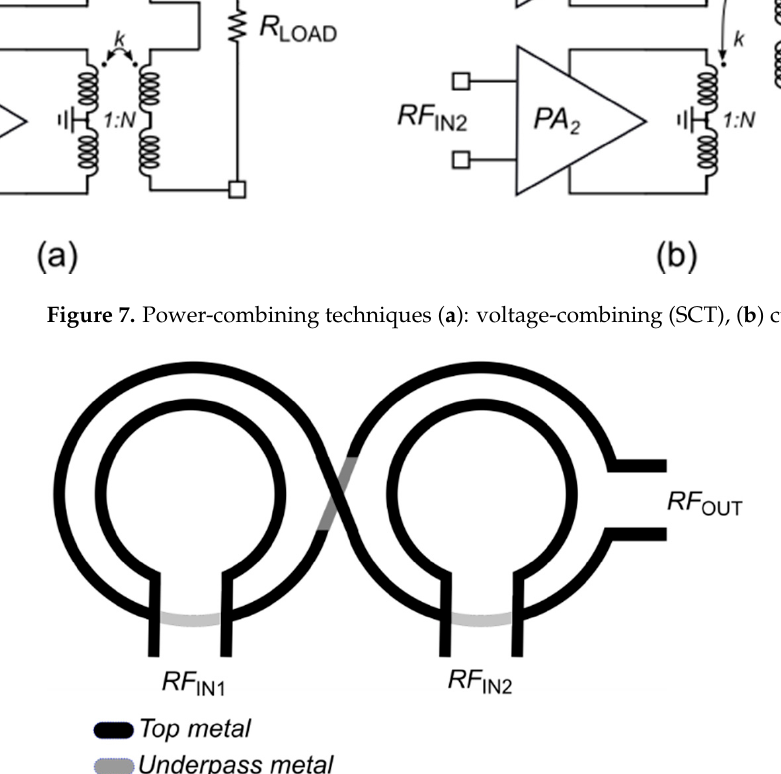
Figure 7. Power-combining techniques ( a ): voltage-combining (SCT), ( b ) current-combining (PCT).